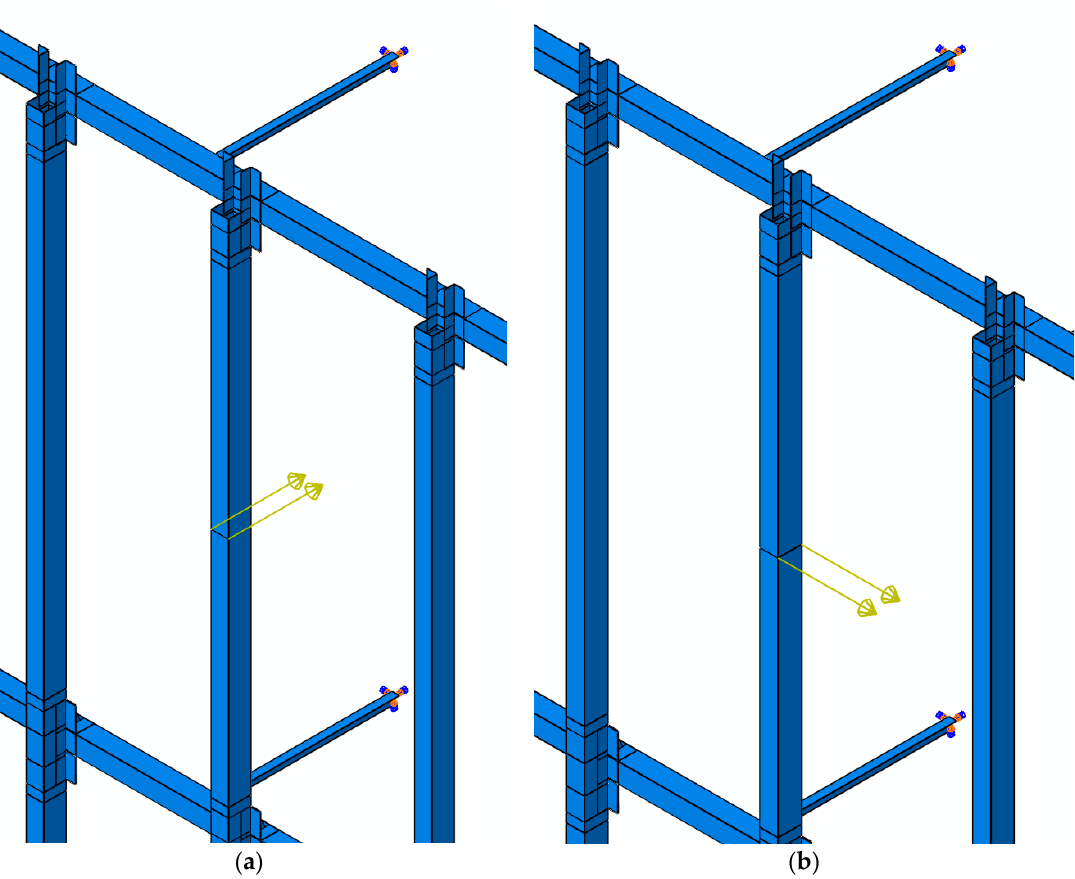
Figure 12. Structure model, support, and loads: ( a ) applying face force; ( b ) applying side force.